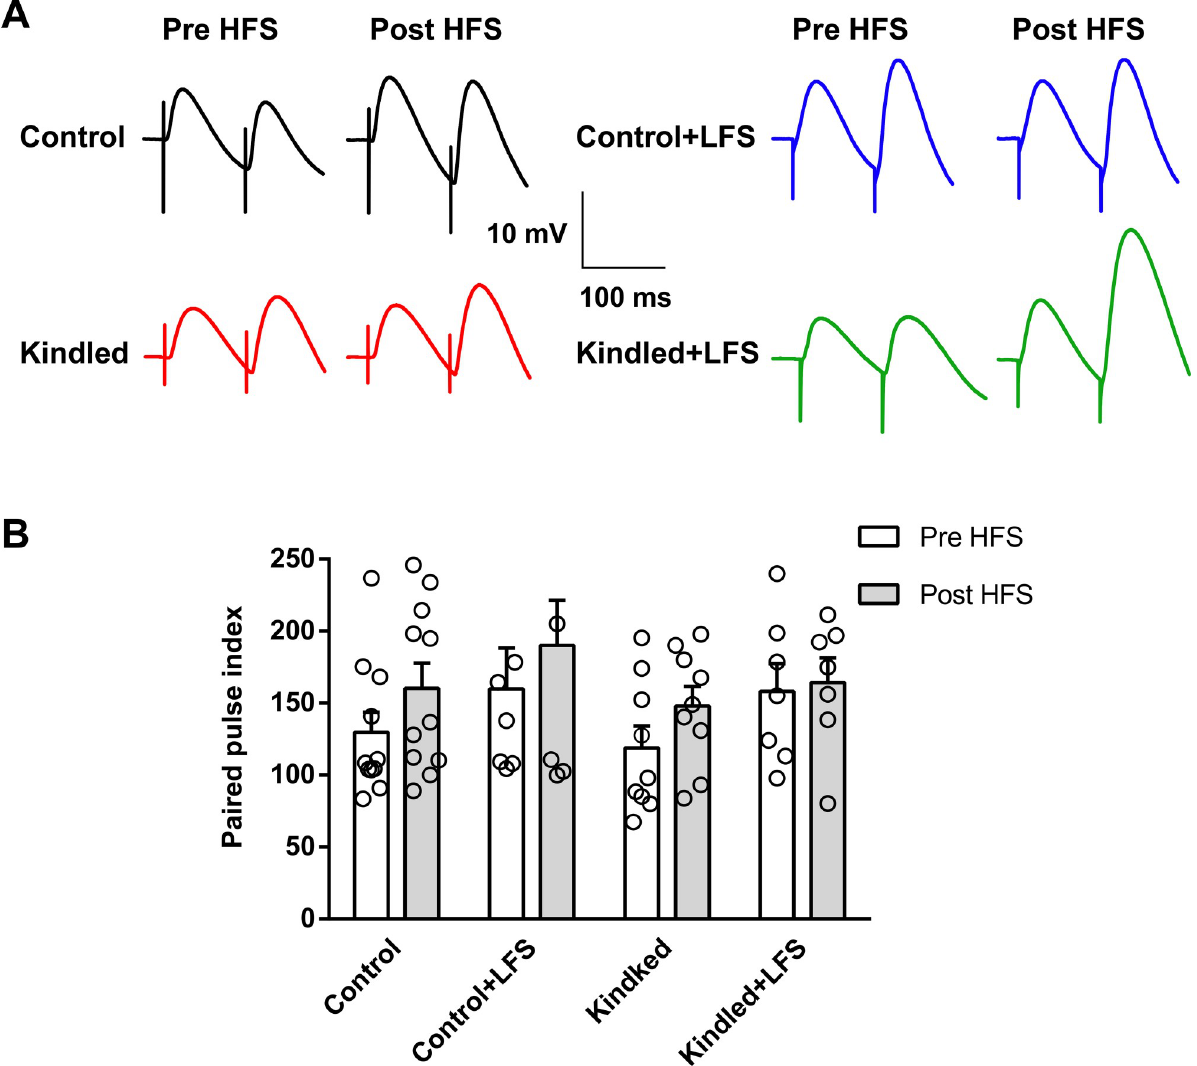
Fig 4. Effect of LFS on PPI of IPSPs before and after HFS application in hippocampal slices of different experimental groups. (A) Sample recording of IPSPs paired pulse in different experimental groups. No significant change in PPI of IPSPs was observed before and after HFS application in the control, control+LFS, kindled or kindled+LFS group. Control: n = 11, Control+LFS: n = 7, Kindled: n = 9, Kindled+LFS: n = 7. Data are shown as mean ± SEM.